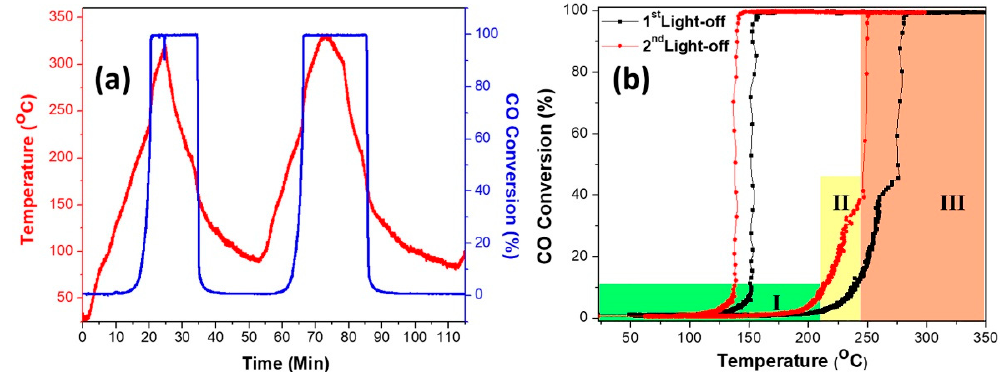
Figure 1. ( a ) Reaction temperature and carbon monoxide (CO) conversion efficiency during typical light-off testing in a synthetic gas reactor as a function of time, ( b ) CO conversion efficiency, and hysteresis effect as a function of the reaction (catalyst)